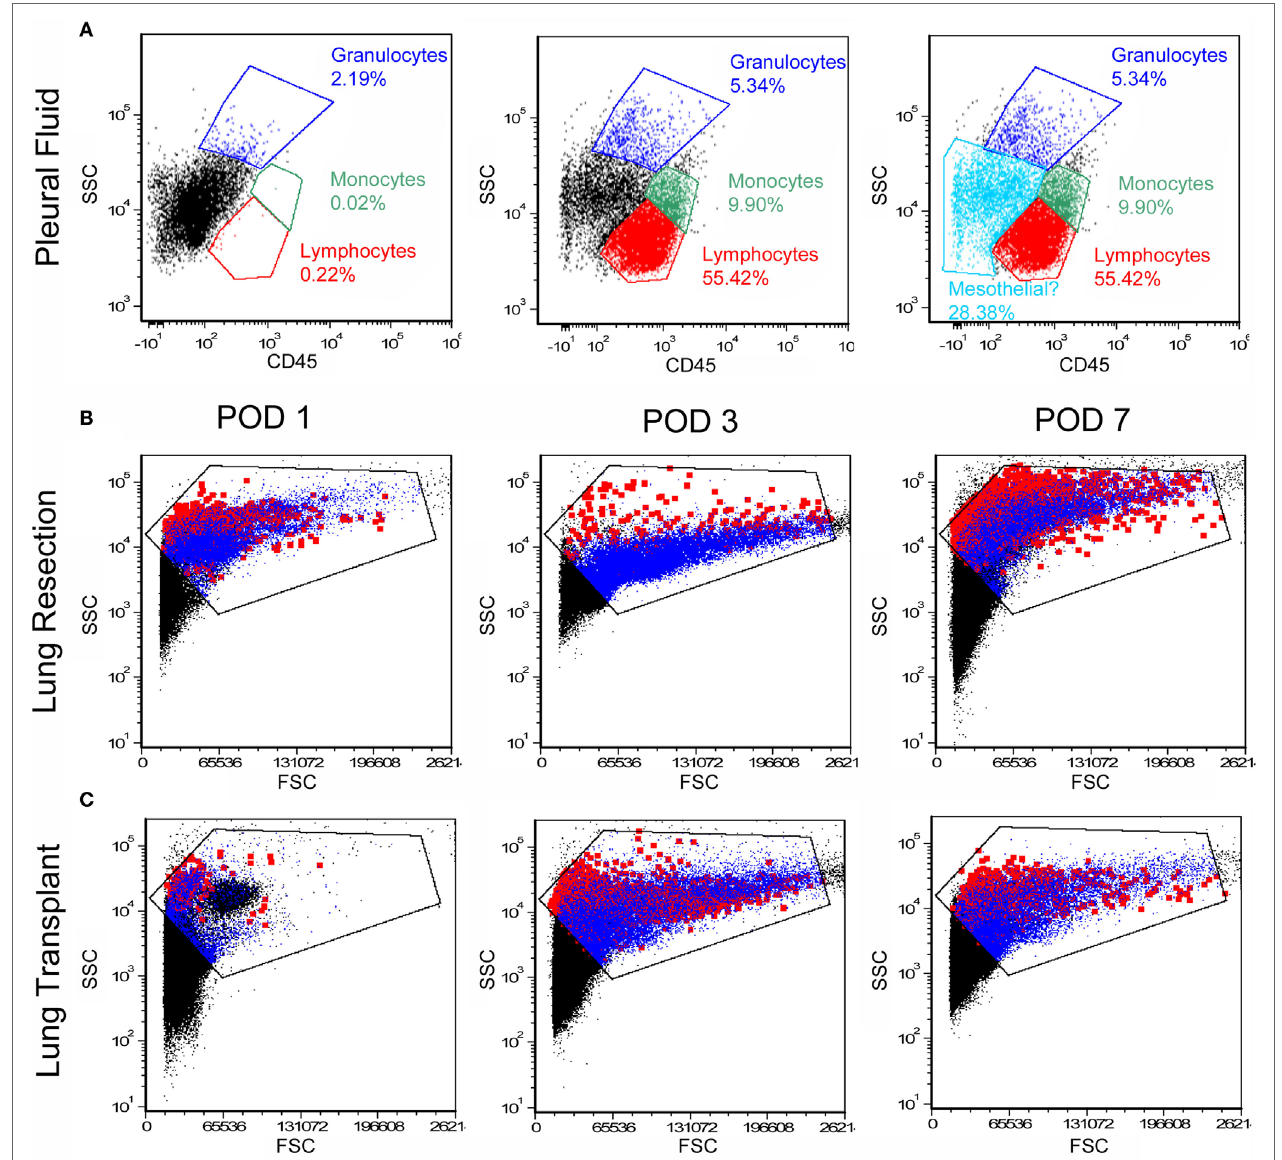
FigUre 2 | Flow cytometry profile of cells in the pleural fluid. After exclusion of debris and red cells, the remaining cells were studied by flow cytometry. (a) Anti-CD45 staining and side-scatter (SSC) analysis demonstrated a dominant mononuclear population. A representative sample on day 1 after surgery demonstrated 70% mononuclear cells and 5% granulocytes; the remaining 25% of cells were compatible with mesothelial cells. Unstained negative controls were compared to samples stained with detection antibodies (B,c) . More detailed size analysis with forward light scatter (FSC) on postoperative day 1, 3, and 7 showed no consistent size relationship between CD45 + cells (blue) and CD45 − cells (red; the Emphasize Plot Tool, FCS Express, was used for data presentation). Representative histograms are